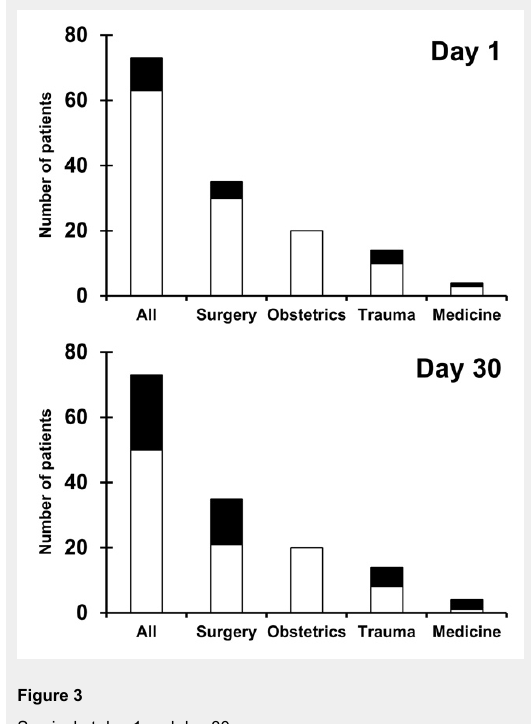
Survival at day 1 and day 30. Survival and in-hospital mortality data on day 1 and up to day 30 for all patients and for categories of patients after off-label use of recombinant factor VIIa (rFVIIa). Deceased patients are shown in black, living patients are shown in white.